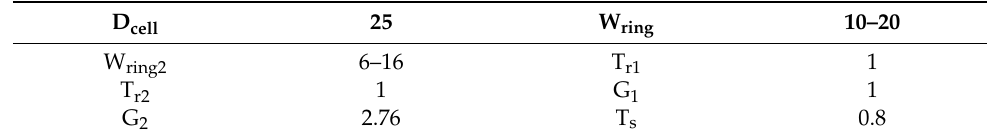
Figure 2. Unit-cell geometry: ( a ) top and ( b ) side views. Table 1. Unit-cell Design Parameters in mm.